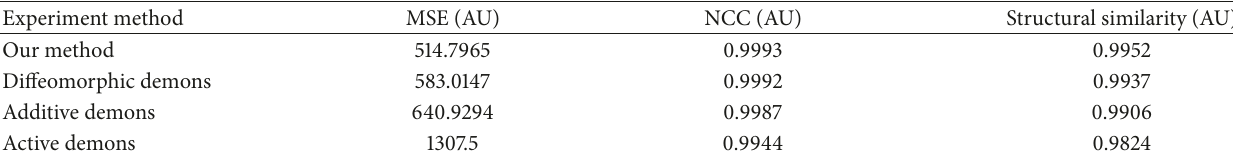
Figure 2: Algorithm flow. Table 1: Evaluation of registration